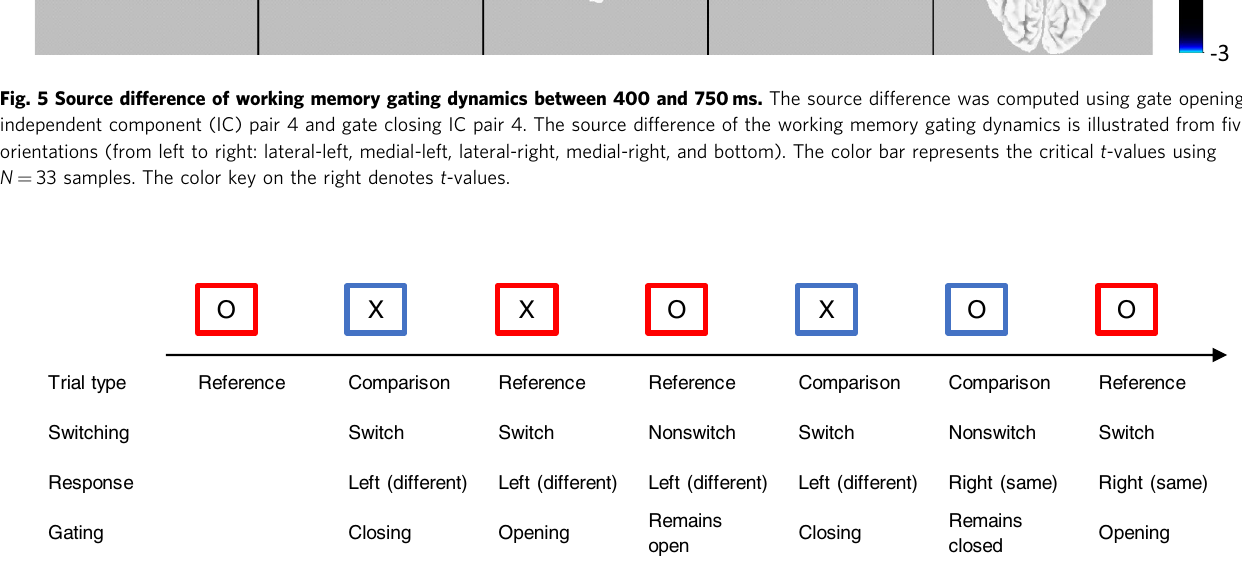
Fig. 6 An example of the reference-back task. The arrow indicates the stimulus presentation